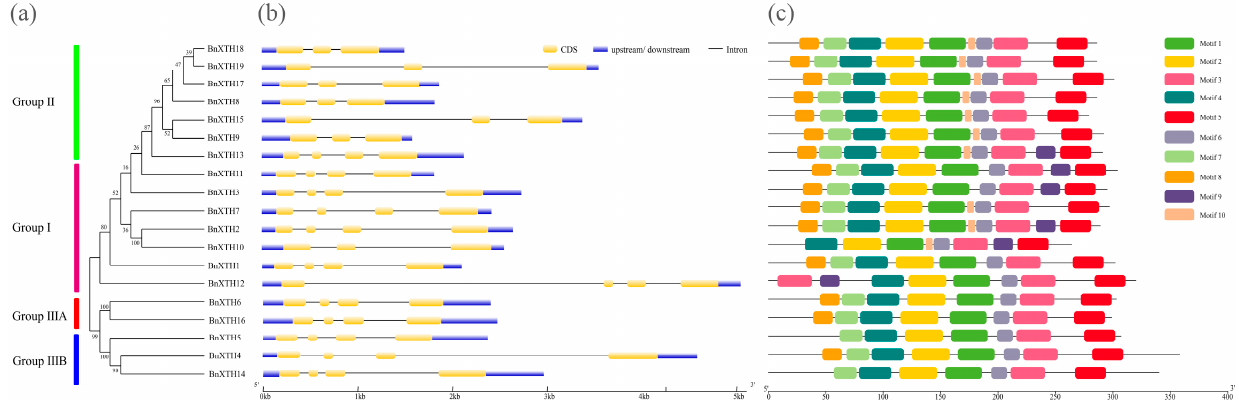
Figure 3. Phylogenetic ( a ), gene-structure ( b ), and conserved motif ( c ) analyses of the BnXTH gene family.